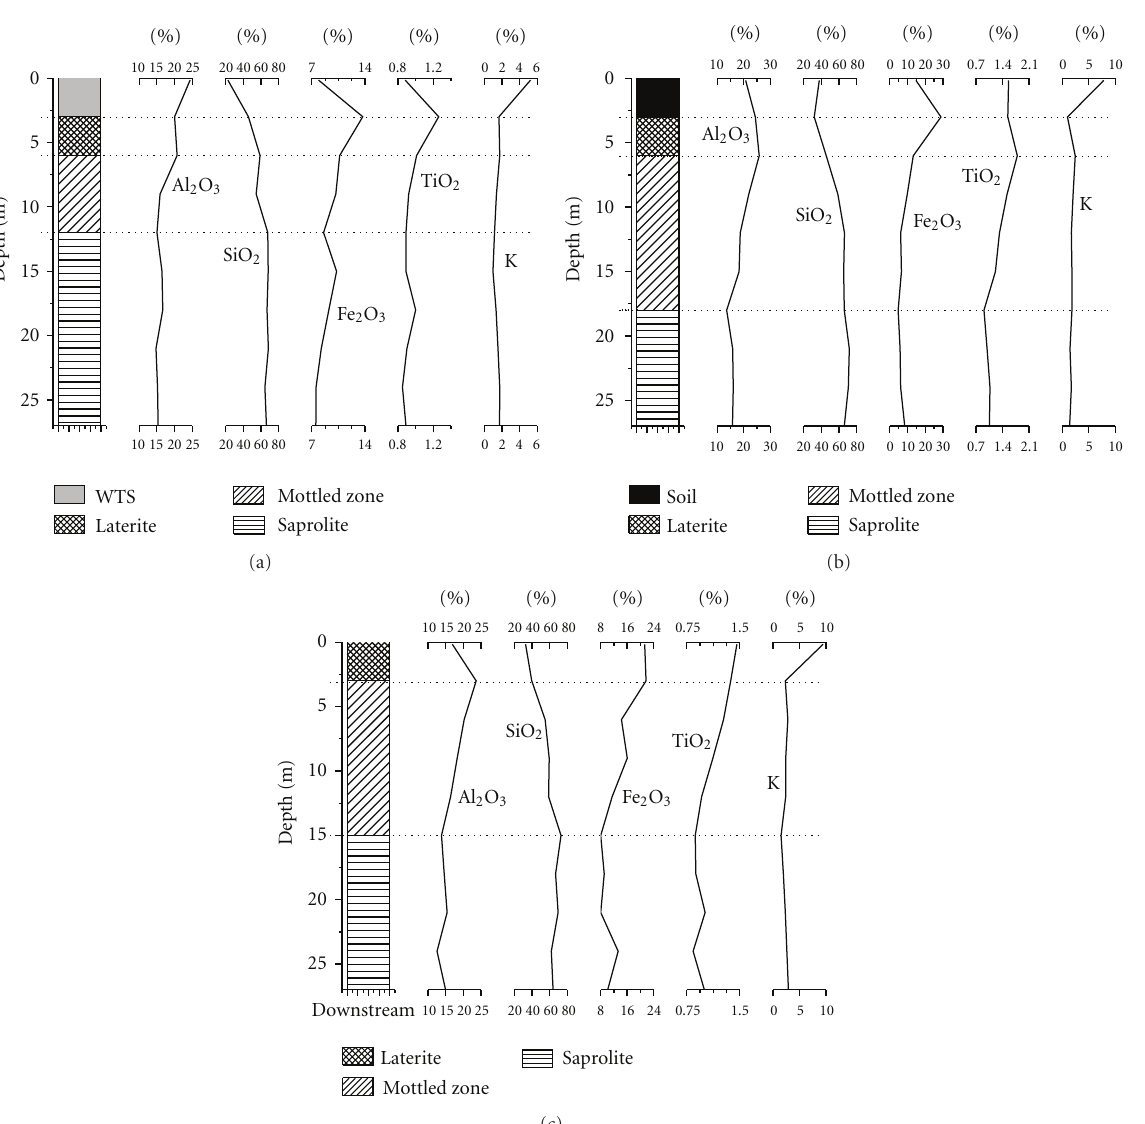
bottom to top in a lateritic profile. Several of these